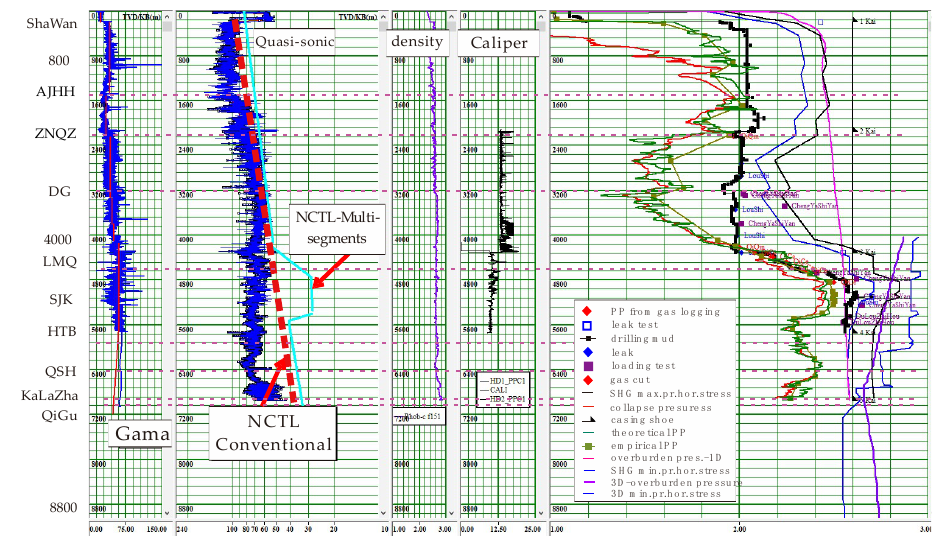
Figure 10. Pore pressure prediction and mud weight window results based on 3D geostress and velocity analysis.